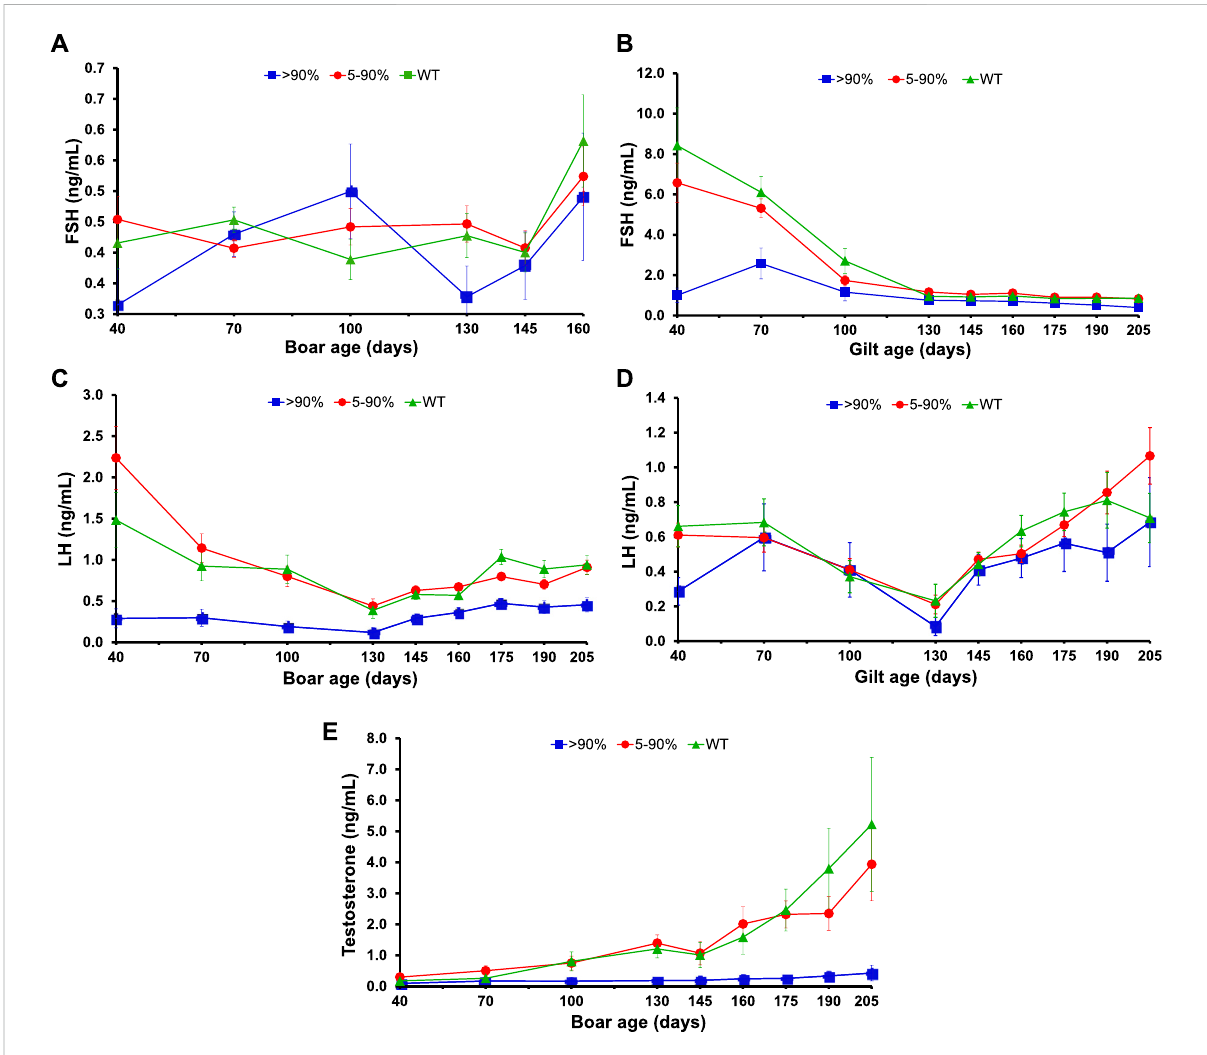
FIGURE 4 Hormone pro fi les of KISS1 -edited pigs. (A – D) Serum concentration (LSmeans ± SE) in boars and gilts of FSH [ (A) and (B) , respectively] and LH [ (C) and (D) , respectively] during development by KISS1 -disruption group. (E) Developmental change in serum concentrations (LS means ± SE) of testosterone in boars according to the KISS1 -disruptive editing